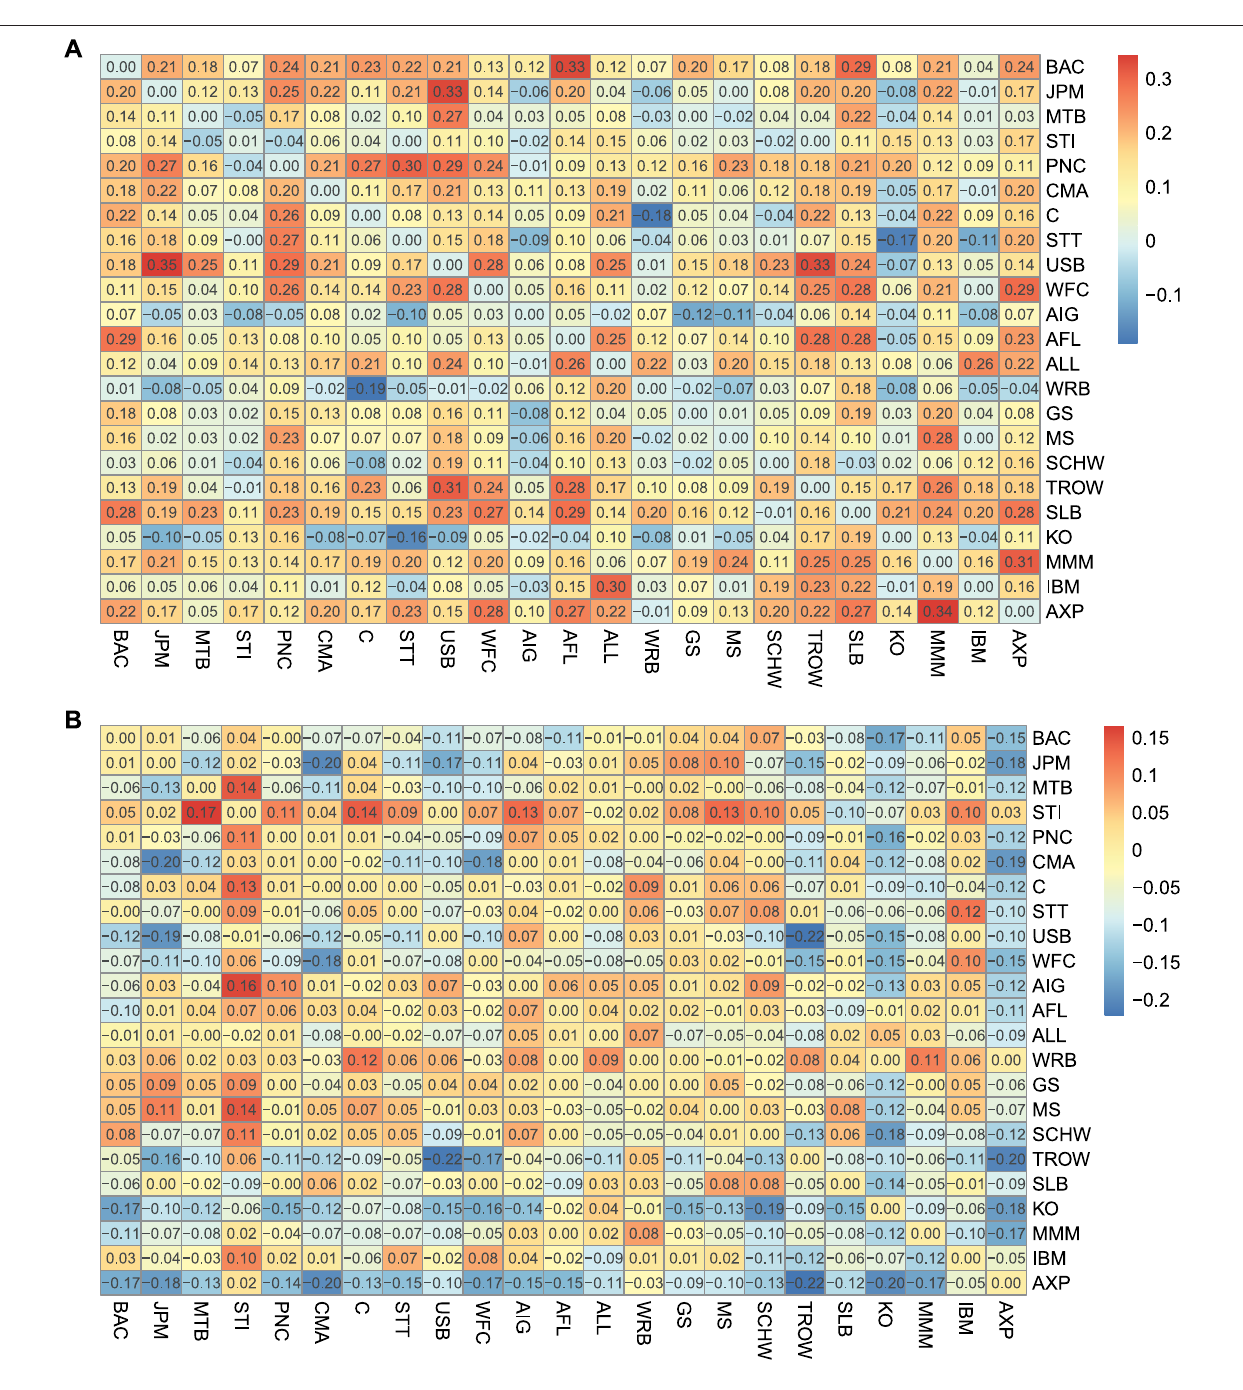
FIGURE 1 | Systemic linkage variation table for the US SIFIs. (A) Systemic linkage variation table from stage 1 to stage 2. (B) Systemic linkage variation table from stage 2 to stage 3.